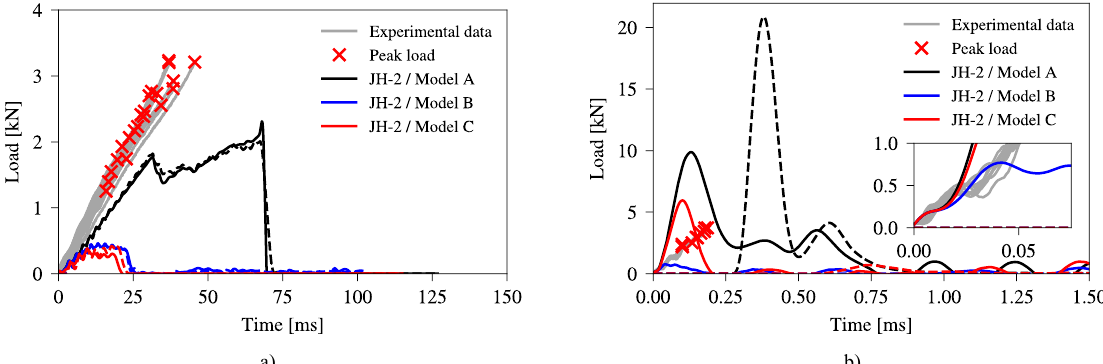
Fig. 9 Simulation results for the three considered JH-2 models compared to experimental data for target piston velocities of a) 10 mm/s, and b) 1000 mm/s. (― load ring; - - - support ring).